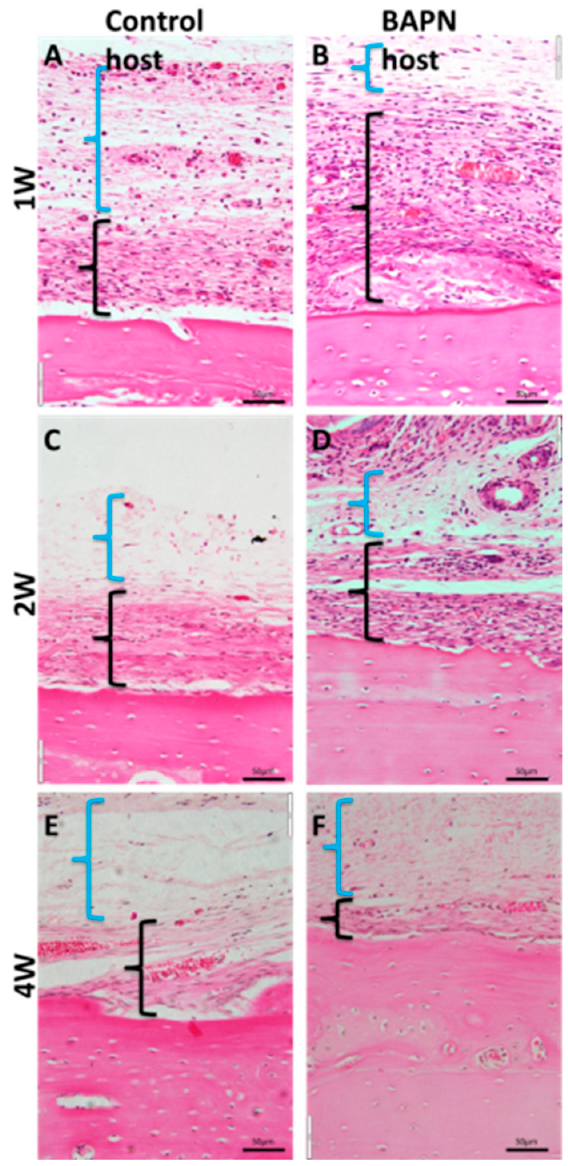
Figure 6. Hematoxylin and eosin staining of host periosteum surrounding transplanted bone chips at three times points. ( A , C , E ) Control host animals; ( B , D , F ) BAPN host animals. The outer fibrous layer is indicated by blue brackets. The cambium layer is indicated by black brackets. At Week 1, the cambium layer is thinner in the control host than in the BAPN host. Magnification, ×40.